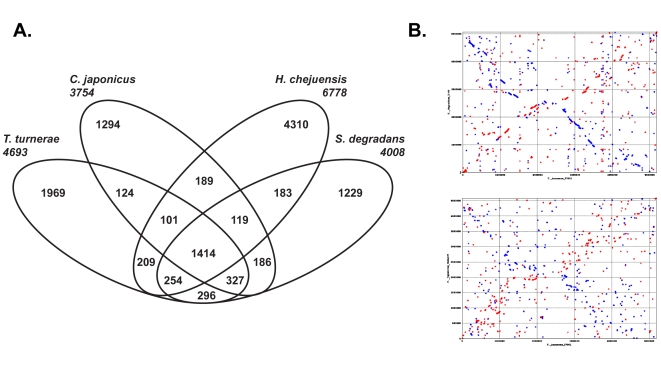
Genomic comparison of T. turnerae, S. degradans, H. chejuensis and C. japonicus.(A) Venn diagram portraying occurrence of predicted protein coding genes of homologous origin shared among the genomes of T. turnerae, S. degradans, H. chejuensis and C. japonicus. (B) Synteny of predicted protein coding genes among the genomes of T. turnerae (x-axis, top and bottom) and S. degradans (y-axis, top) and C. japonicus (y-axis, bottom) inferred using PROmer (PROtein MUMmer)[102]. Circular chromosomes are depicted linearly with the origins of replication at map coordinates (0,0). Dots depict location of homologous proteins relative to the origins with red and blue representing homology on the same or opposite strand, respectively.